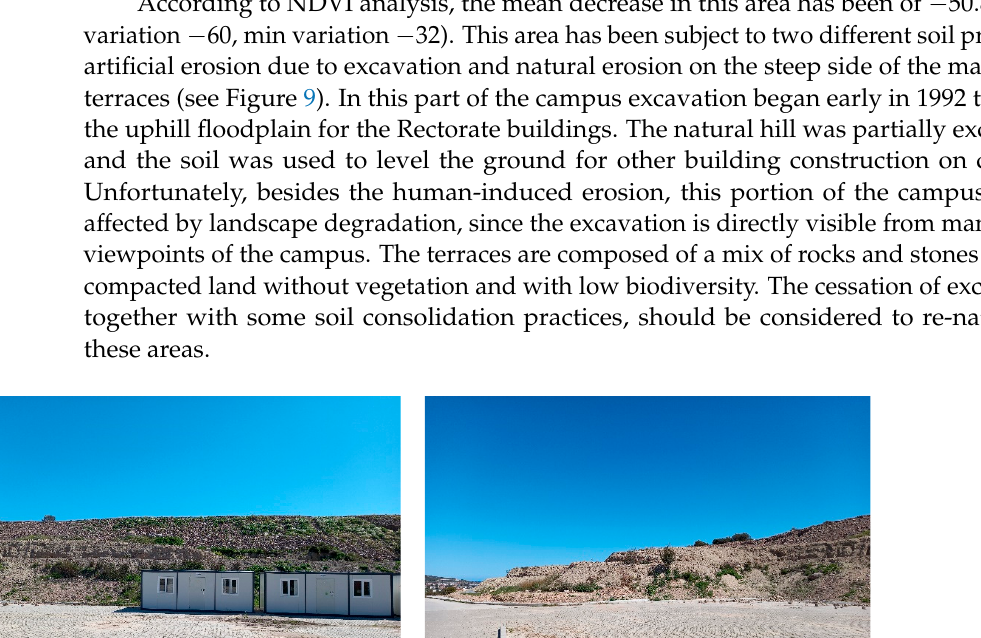
Figure 8. Creation of banks along the main road of the campus.